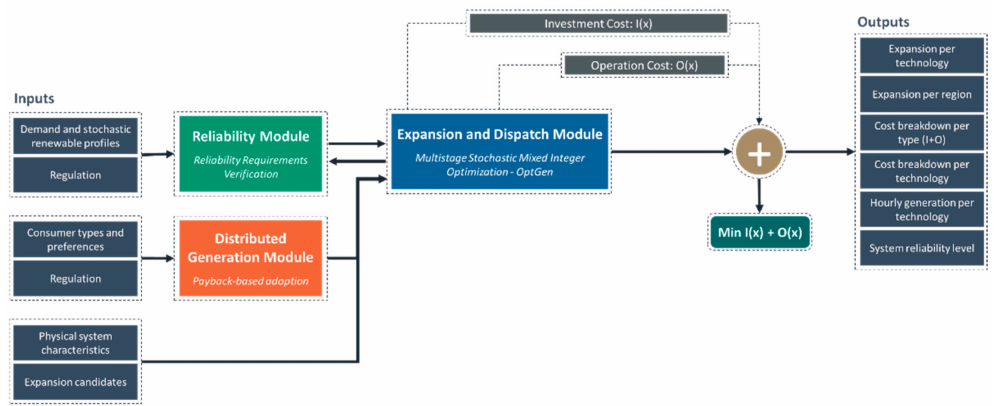
Figure 1. General scheme of the methodology